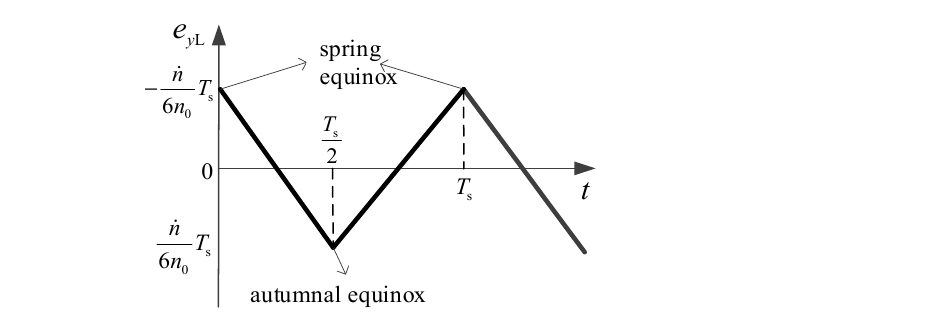
Figure 3. The eccentricity vector on the Y -axis component caused by the mean longitude